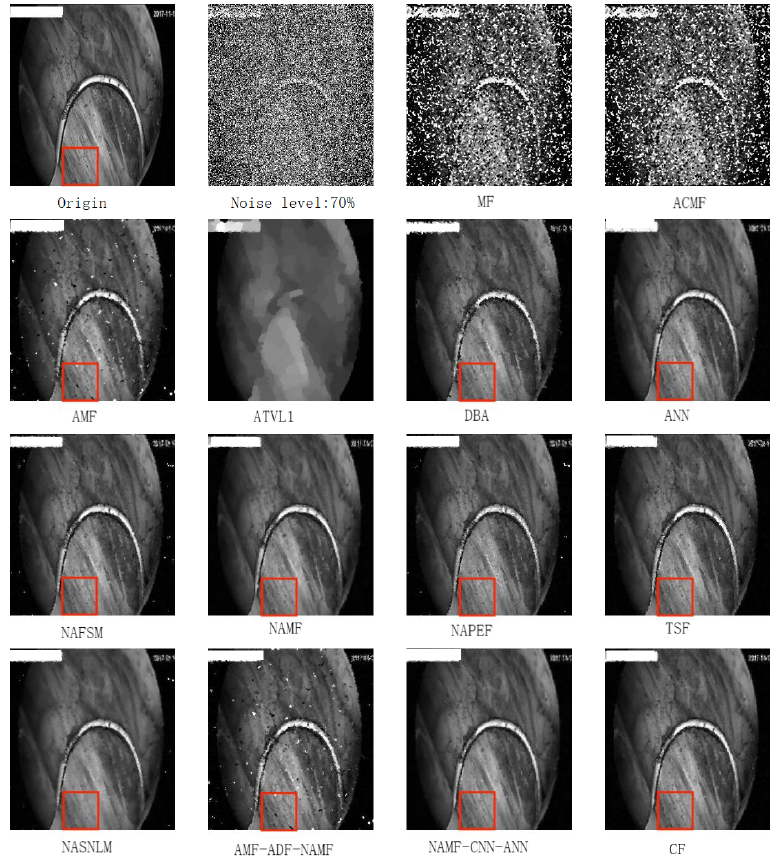
Figure 1. CF results for denoising, compared with fourteen different methods.